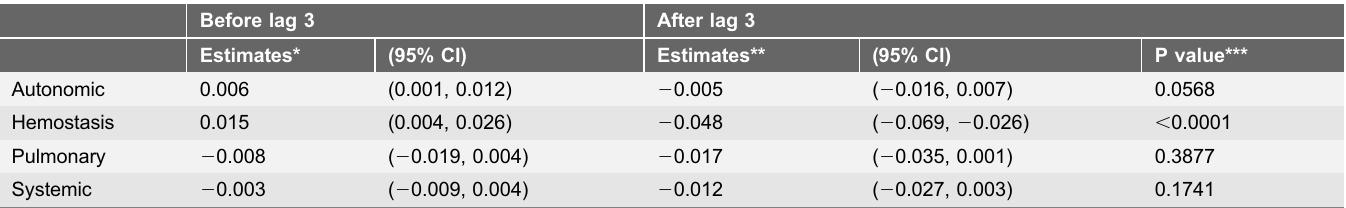
) between standardized 24 hour average pollutant bpl